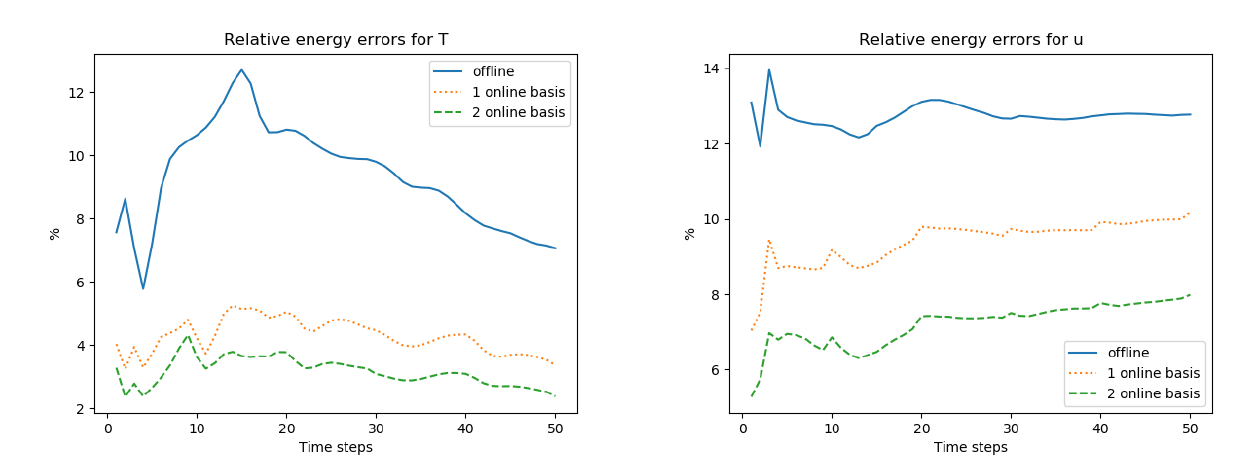
Figure 13. Relative L 2 and energy errors (%) for multiscale solutions using 4 offline basis functions and 1 and 2 online basis functions (enrichment periodicity is